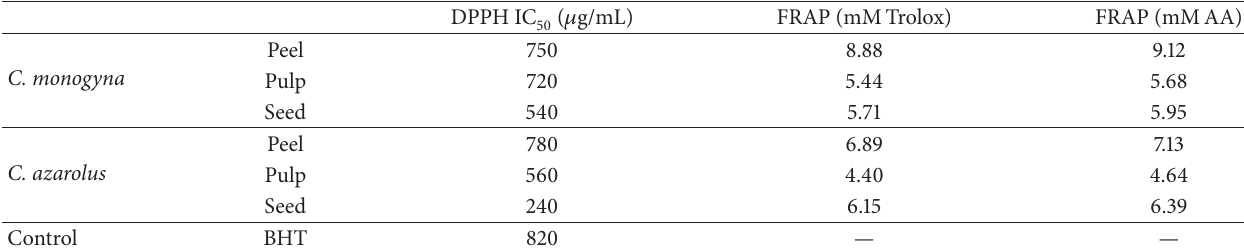
Table 2: Free radical scavenging capacity, FRAP assay, and standard antioxidants of Crataegus fruit extract.